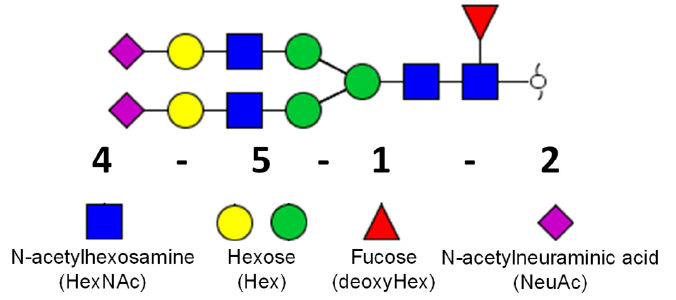
Figure 1. Nomenclature of glycan structure used in this study. Glycan depicted above represents the composition of four HexNAc, five Hex, one deoxyHex, and one NeuAc (4-5-1-2). The green circle represents mannose and the yellow circle represents galactose.